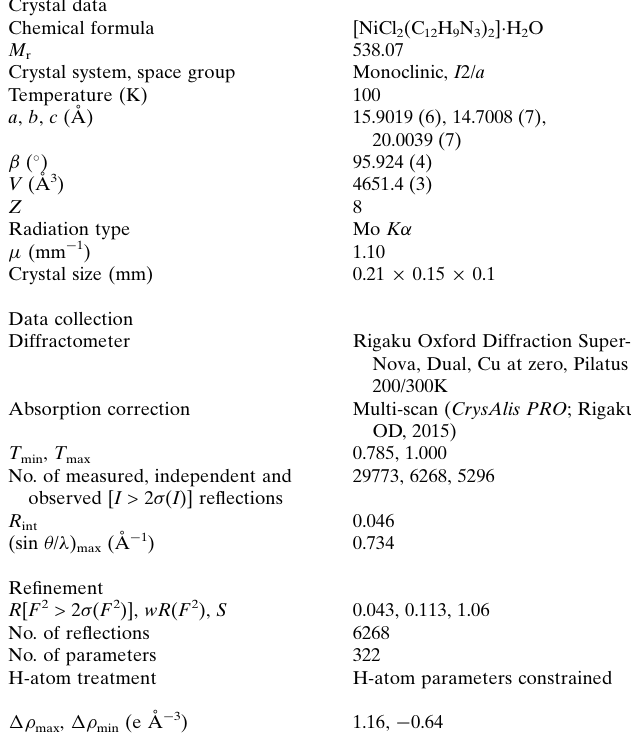
Crystal data Chemical formula